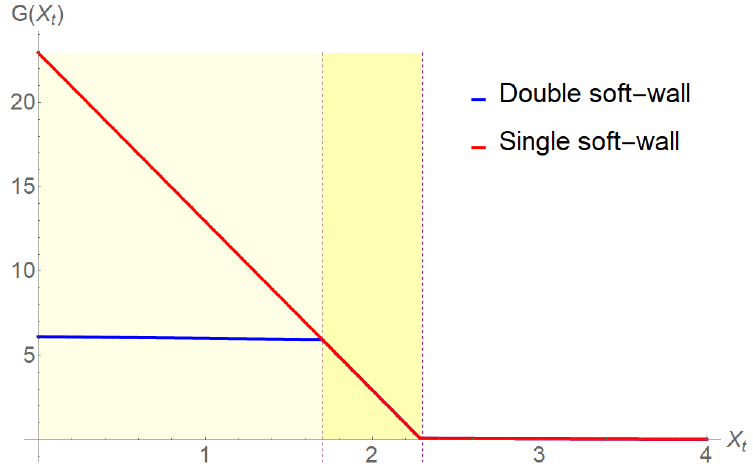
Figure 5. Single (21) and double “increase–decrease” (22) force F profiles for k 1 = 0.001, k 2 = 10, k 3 = 0.1, a 1 = 2.3, a 2 =